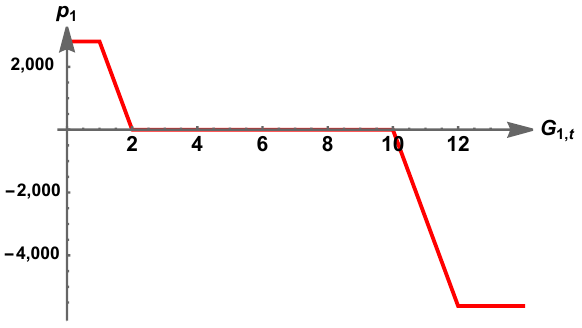
Figure 12. Pay-off of the collar option p 1 ( G 1, t )